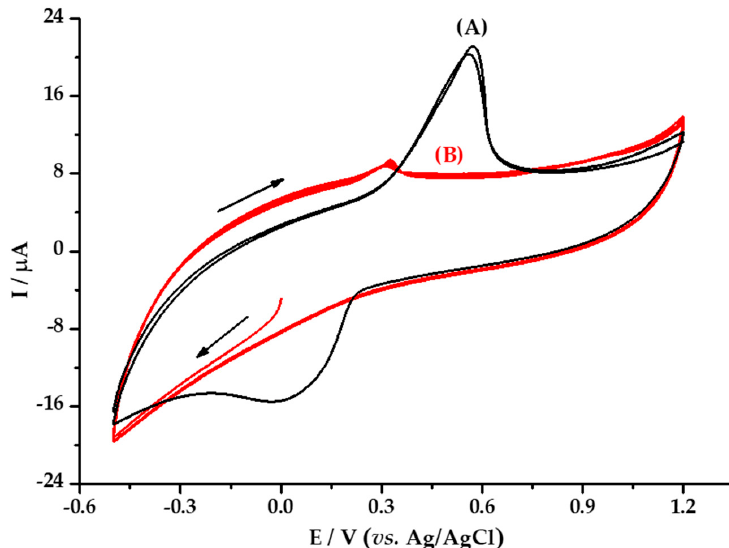
Figure 9. Cyclic voltammograms of: ( A ) 5 mmol L − 1 AgNO 3 + 0.10 mol L − 1 sodium acetate solution, ( B ) Ma AgNPs in 0.10 mol L − 1 sodium acetate solution; on GC work electrode. Scanning rate 50 mV/s vs. Ag/AgCl at 25 °C.